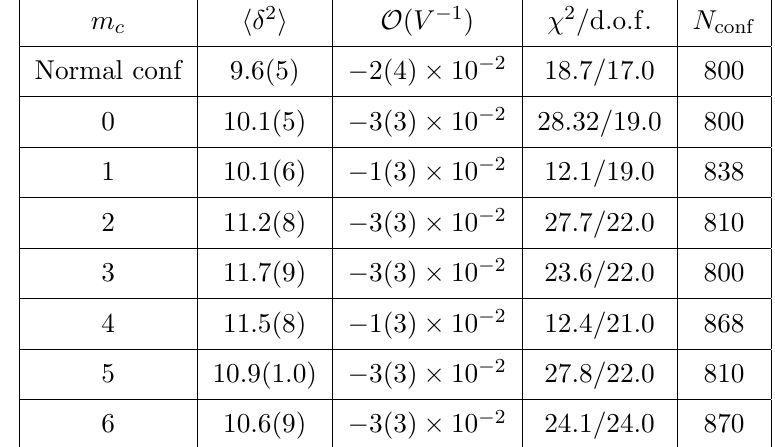
Figure 4 . Comparisons of the histogram H ( Q ) of the topological charges Q of the normal con(cid:12)g- urations (upper left) and the magnetic charges m c = 2 (lower left), 4 (upper right), and 6 (lower right). The black lines indicate the (cid:12)tting results according to the distribution functions for each magnetic charge.